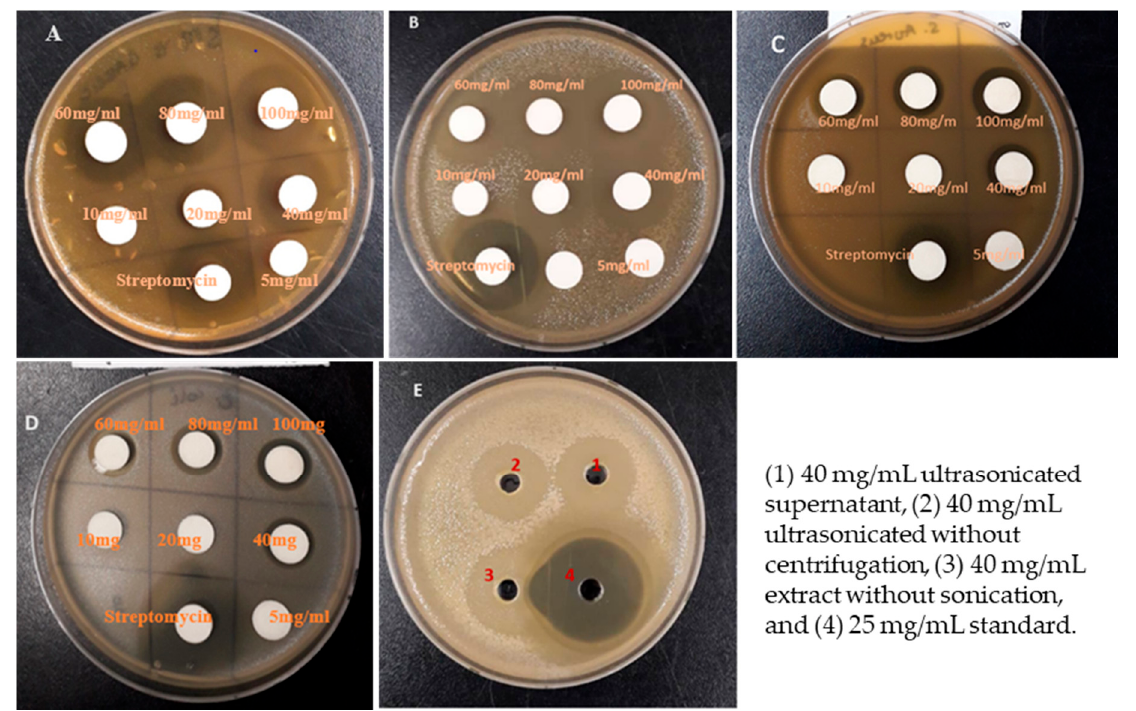
Figure 1. Antibacterial activity of different concentrations of nanoparticles (supernatant) of garlic extract against S. mutans ( A ), P. gingivalis ( B ), S. aureus sub. aureus ( C ), and E. coli ( D ) by agar disk diffusion method. ( E ) represents the antibacterial effect of 40 mg/mL garlic extract treated in different conditions against P. gingivalis by the agar well diffusion method. Table 1. Antibacterial activity of nanoparticles (supernatant) of garlic extract against S. mutans , S. aureus sub. aureus , E. coli , and P. gingivalis by agar disk diffusion method. Garlic Extract